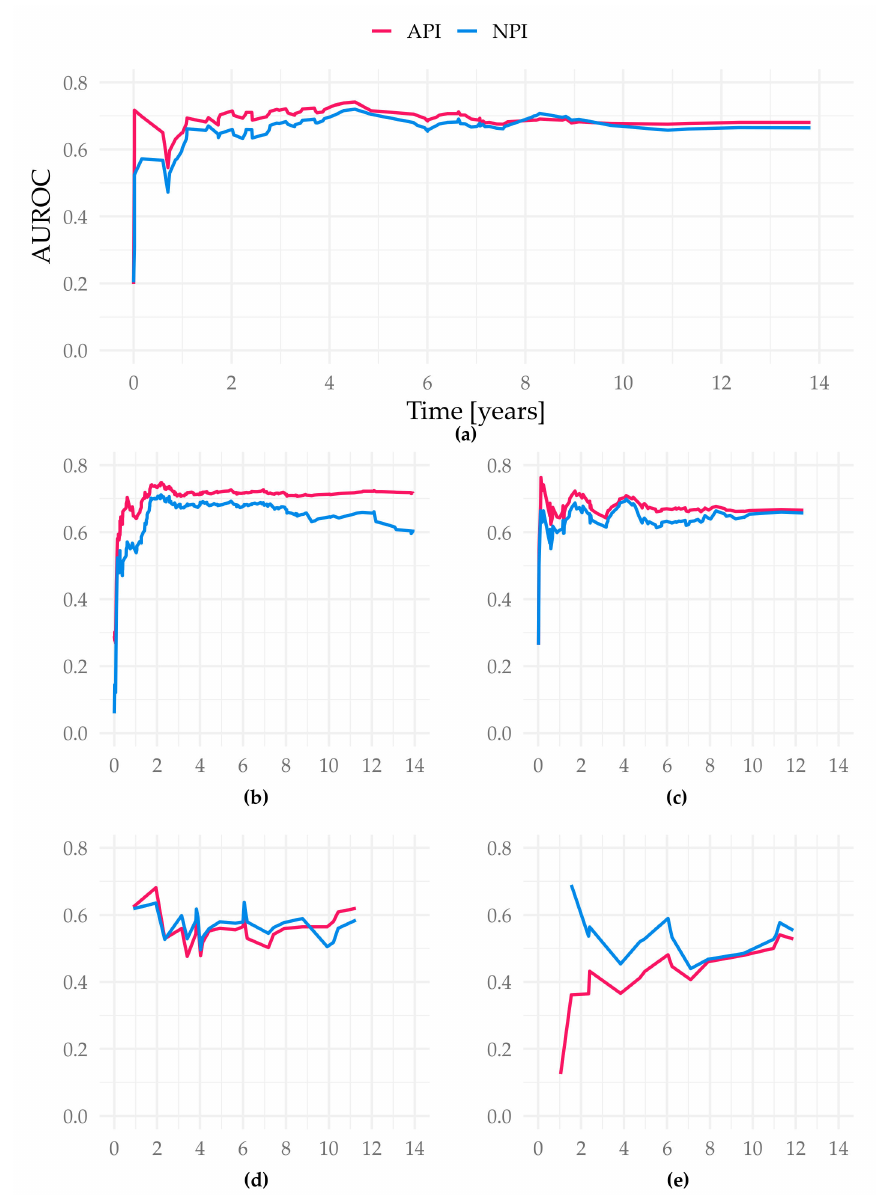
Figure 4. AUROC over time of the different study cohorts in the test sets. Figure ( a ) displays the cohort Subtype NST (=WHO 8500/3), basis for our suggested API; ( b ) Total cohort–6654 patients (gave consent, first primary, unifocal and unilateral tumors); ( c ) filtered cohort–3744 patients (addi- tional filters: only ER-positive, Her2-negative cases, patients ≤ 70 years old); ( d ) all special types (not WHO 8500/3); ( e ) Subtype invasive lobular (=WHO 8520/3); all X -axis present time in years. Y -axis represent the AUROC values at each event time